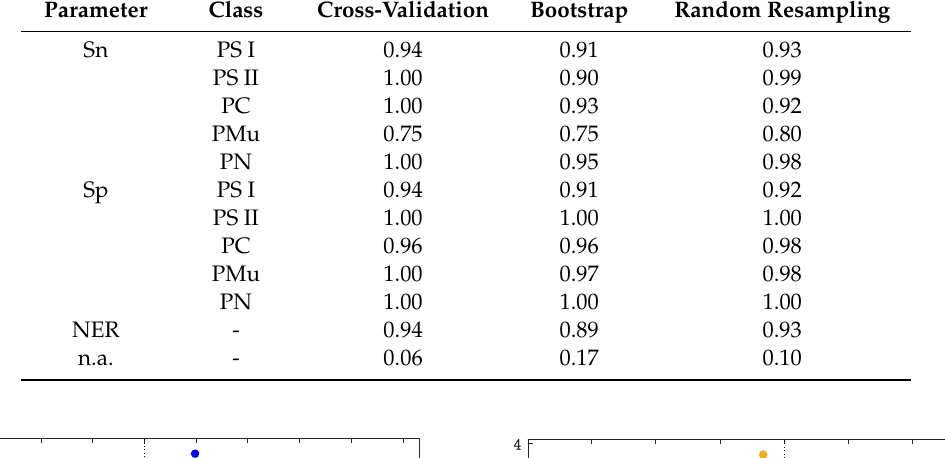
Table 2. Classification parameters of the PLS-DA model in cross-validation, bootstrap and random resampling [61]. Sensitivity (Sn) and specificity (Sp) for each class, along with non-error rate (NER) and ratio of non-assigned compounds (n.a.) are reported.